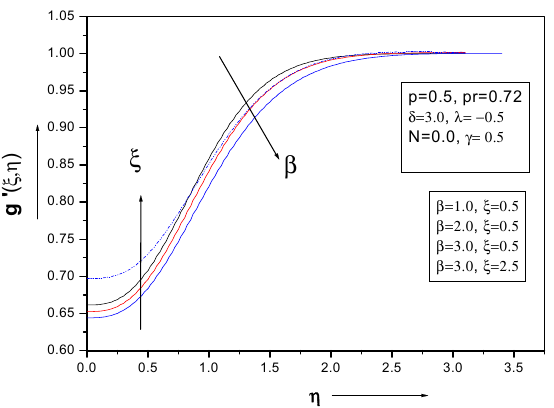
Figure 3. Effect of the magnetic force parameter on temperature profile.